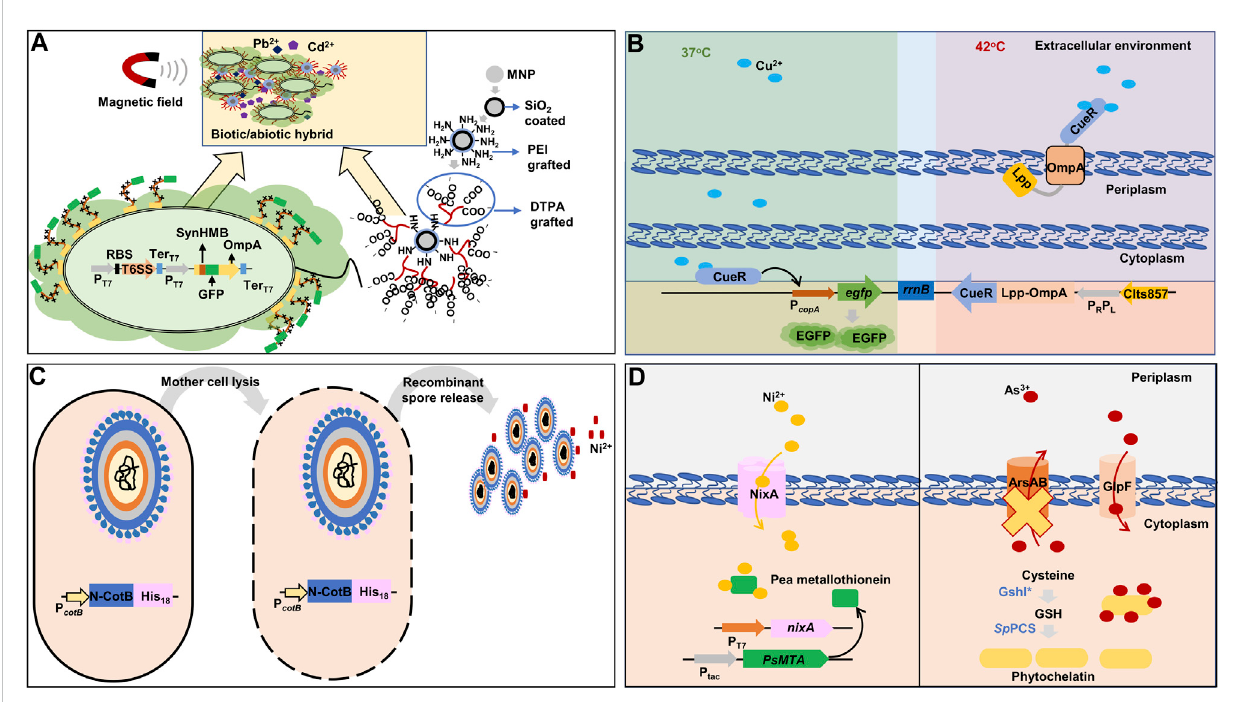
FIGURE 5 Representative synthetic biology approaches for heavy metals bioremediation in bacteria. (A) Combination of synthetic metal-binding peptide for improved extracellular sequestration of lead and cadmium, and chemically modi fi ed magnetic nanoparticles for easy recovery of bacterial cells after decontamination (Zhu et al., 2020). (B) A dual-functional synthetic bacteria for extracellular copper detection and biosorption regulated by thermal change (Wang et al., 2019). (C) Spore surface display with histidine residues to adsorbing nickel (Hinc et al., 2010). (D) Intracellular sequestration of nickelandarsenicbymetallothioneinandphytochelatinwiththeexpressionofrespectiveheavymetalimporters(Singhetal.,2010;Dengetal.,2013).The yellow cross denotes gene deletion. nixA : high-af fi nity nickel-transport protein; PsMTA : pea metallothionein; rrnB : terminator region derived from rrnB gene;ArsAB:arsenicexporter;CIts857:thermosensitive λ repressor;CueR:cooper-transcriptionalregulator;DTPA:diethylenetriaminepentaaceticacid; EGFP: enhanced green fl uorescent protein; Lpp: prolipoprotein; GlpF: arsenic transporter; GSH: glutathione; GshI*: feedback-insensitive ɣ -